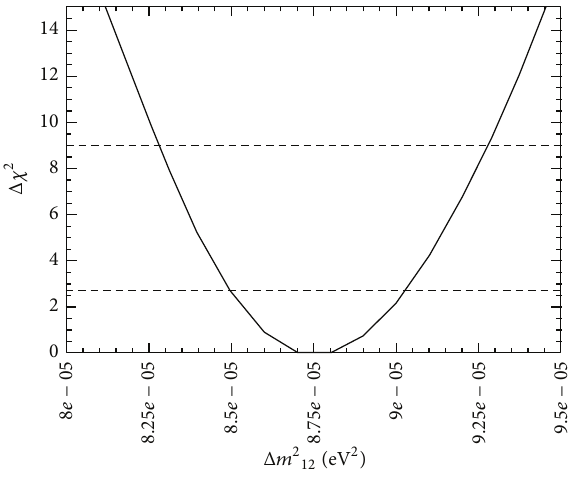
Figure 6: Δ𝜒 2 as a function of Δ𝑚 2 , when the other parameters are fixed in the best fit point, given by (16). Dotted lines indicate, from bottom to top, 90% and 99.73% confidence